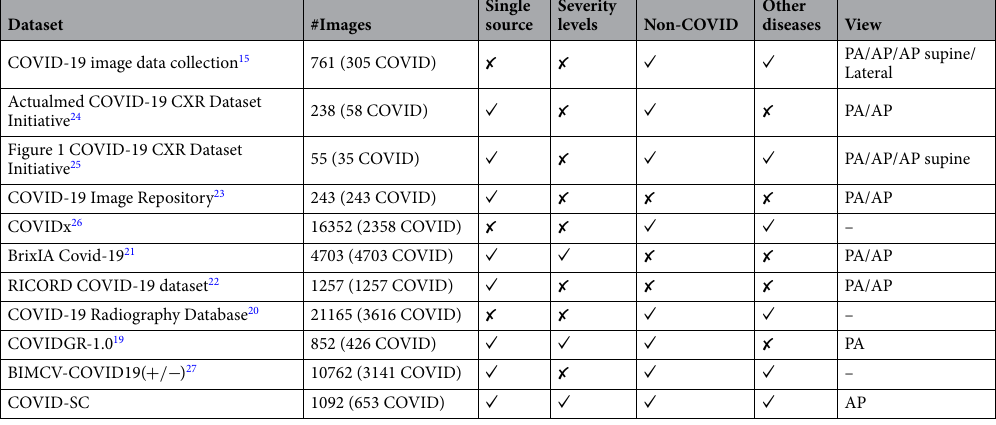
Table 1. Main COVID-19 CXR